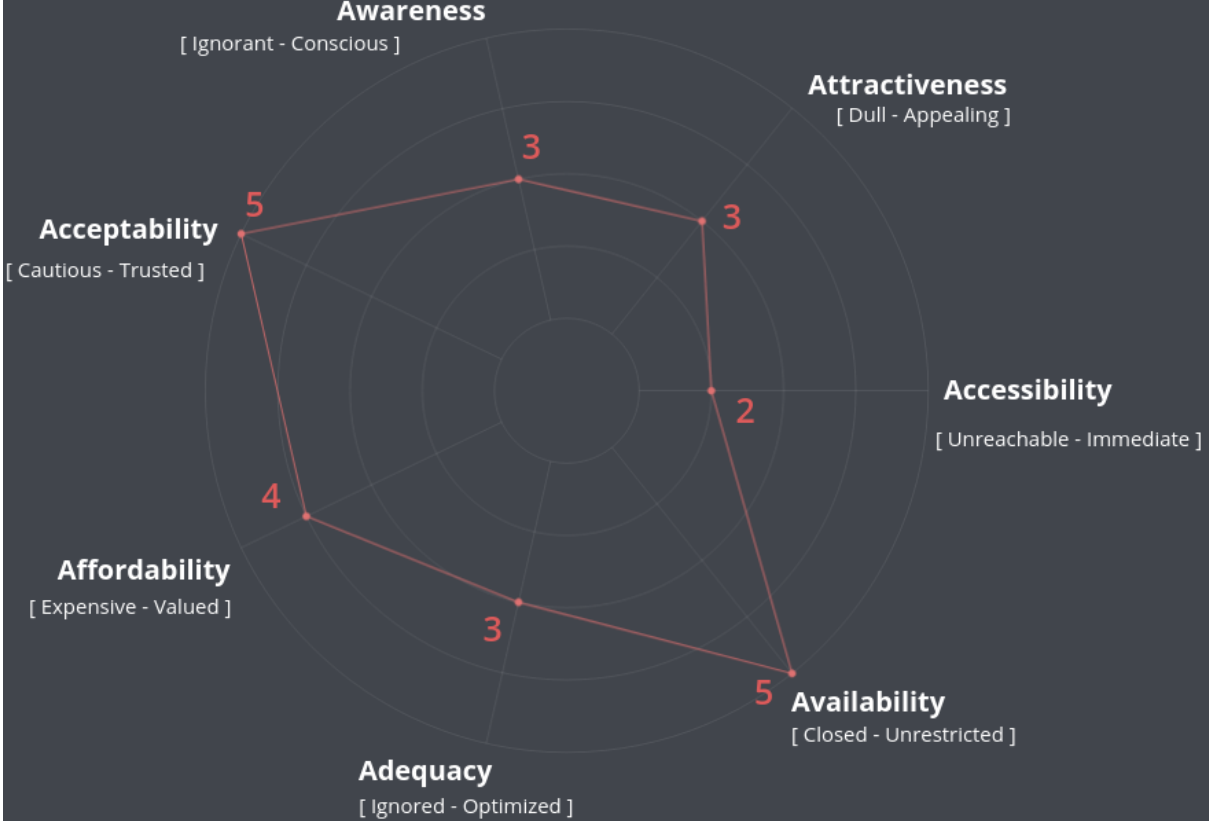
Figure 5. Dimensions estimation for the on-site workshop medium studied for the ZImeysaver